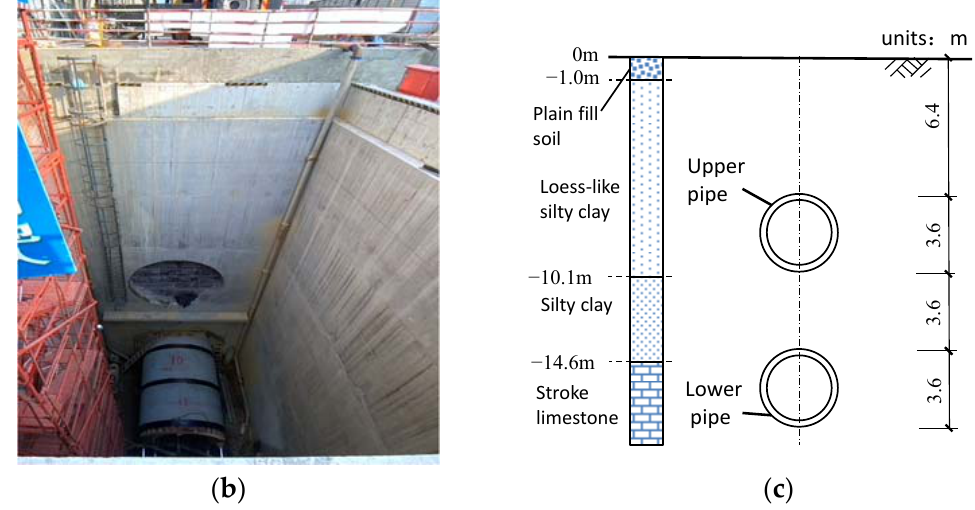
Figure 1. Layout plan of working shafts. ( a ) Layout plan of working shafts and jacking construction route; ( b ) lower pipe jacking; ( c ) vertical arrangement of the pipe and soil distribution.